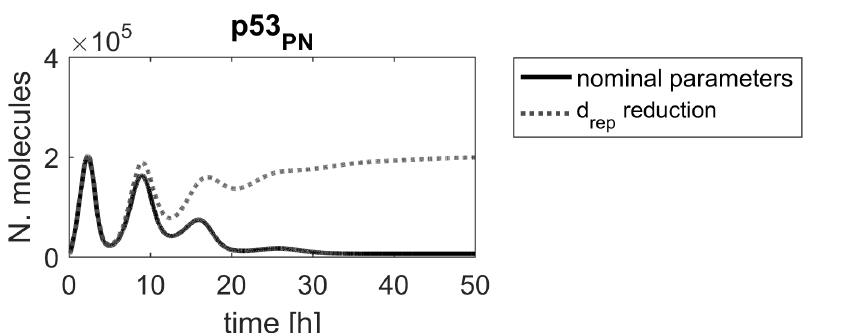
Figure 5. Comparison of p53 protein responses in the model with nominal parameters (black line) and parameter d rep reduced by α = 0.15 (gray dashed line).